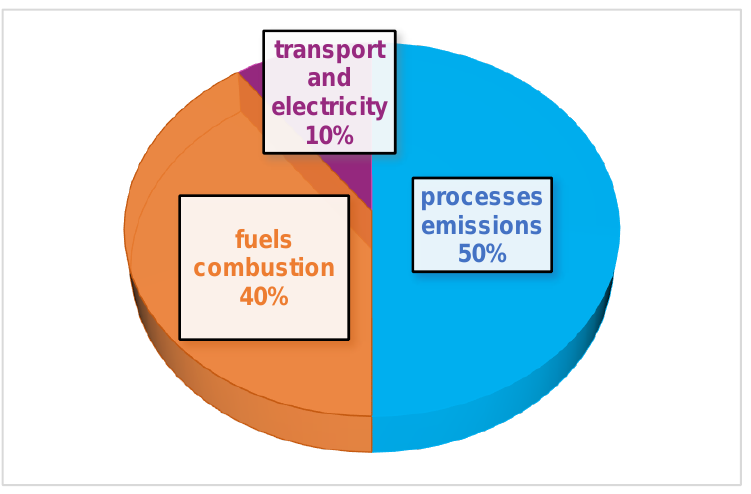
Figure 1. Operations in which CO 2 is generated in the OPC production process [49].